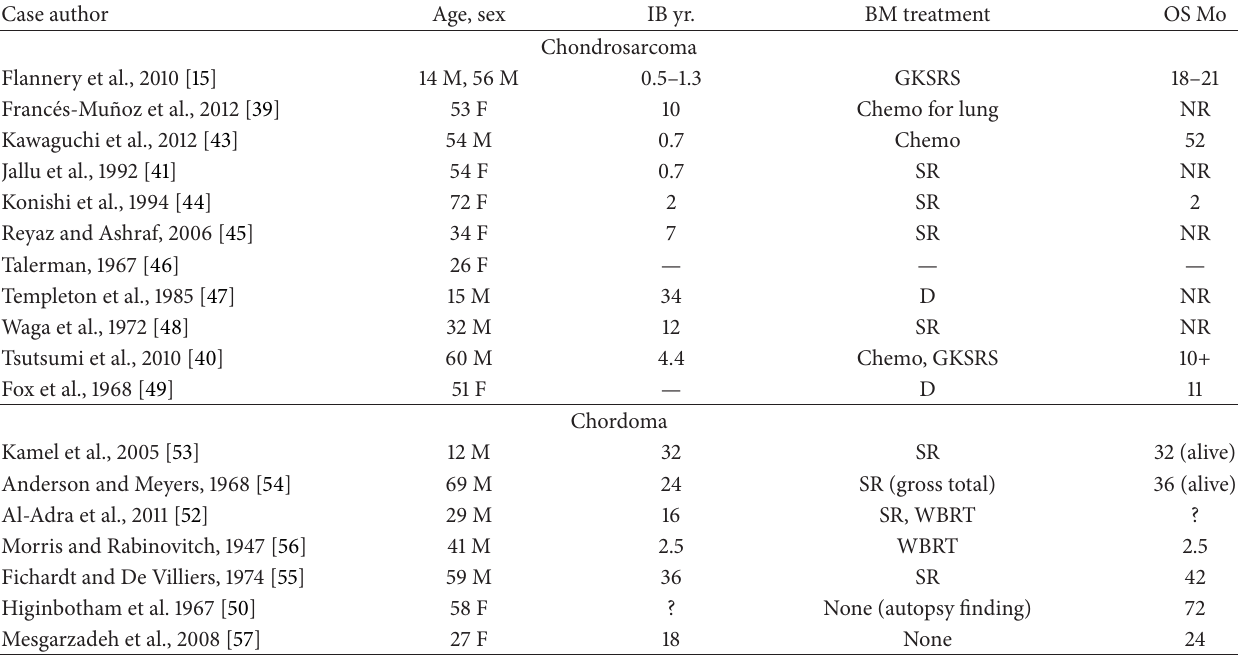
Table 3: Comparison of published reports on patients with brain metastases from chondrosarcoma and